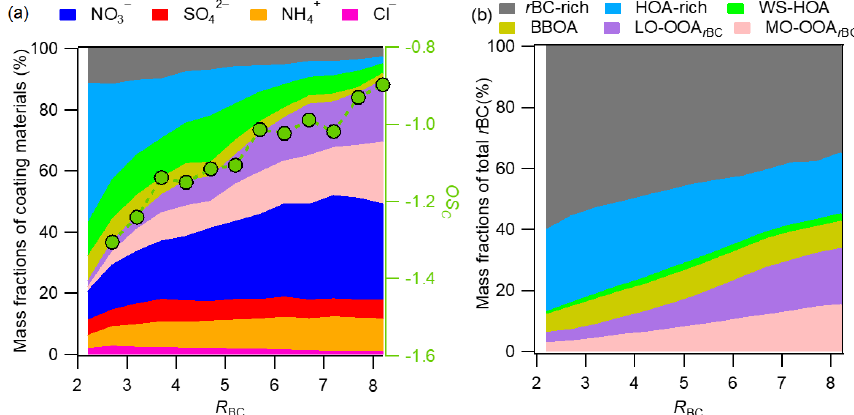
Figure 5. (a) Plot of variations of the mass fractions of the major rBCc-particle components against R BC . (b) Plot of variations of the mass contributions of the individual rBCc-particle OA factors to rBC against R BC